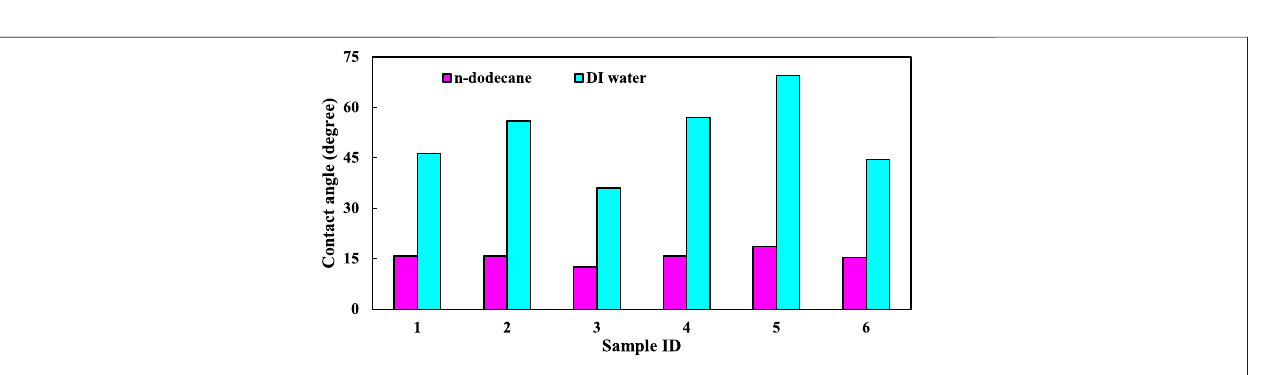
Frontiers in Earth Science |